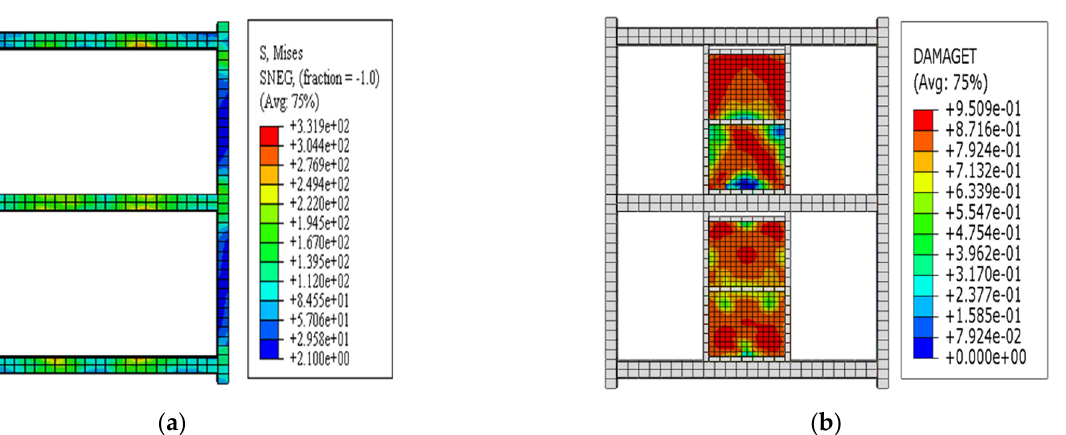
Figure 12. Failure modes of frame F2. ( a ) DAMAGET contour plot of the wall panel element; ( b ) von Mises stress contour plot of the frame.